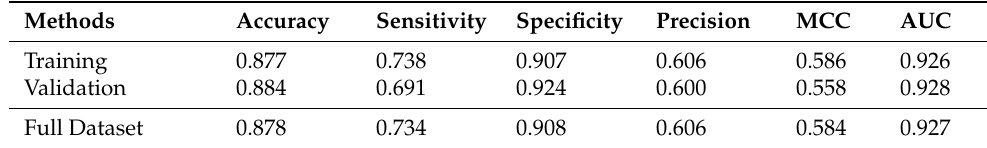
Table 1. Prediction performance of DeepDISE on the training and validation sets.